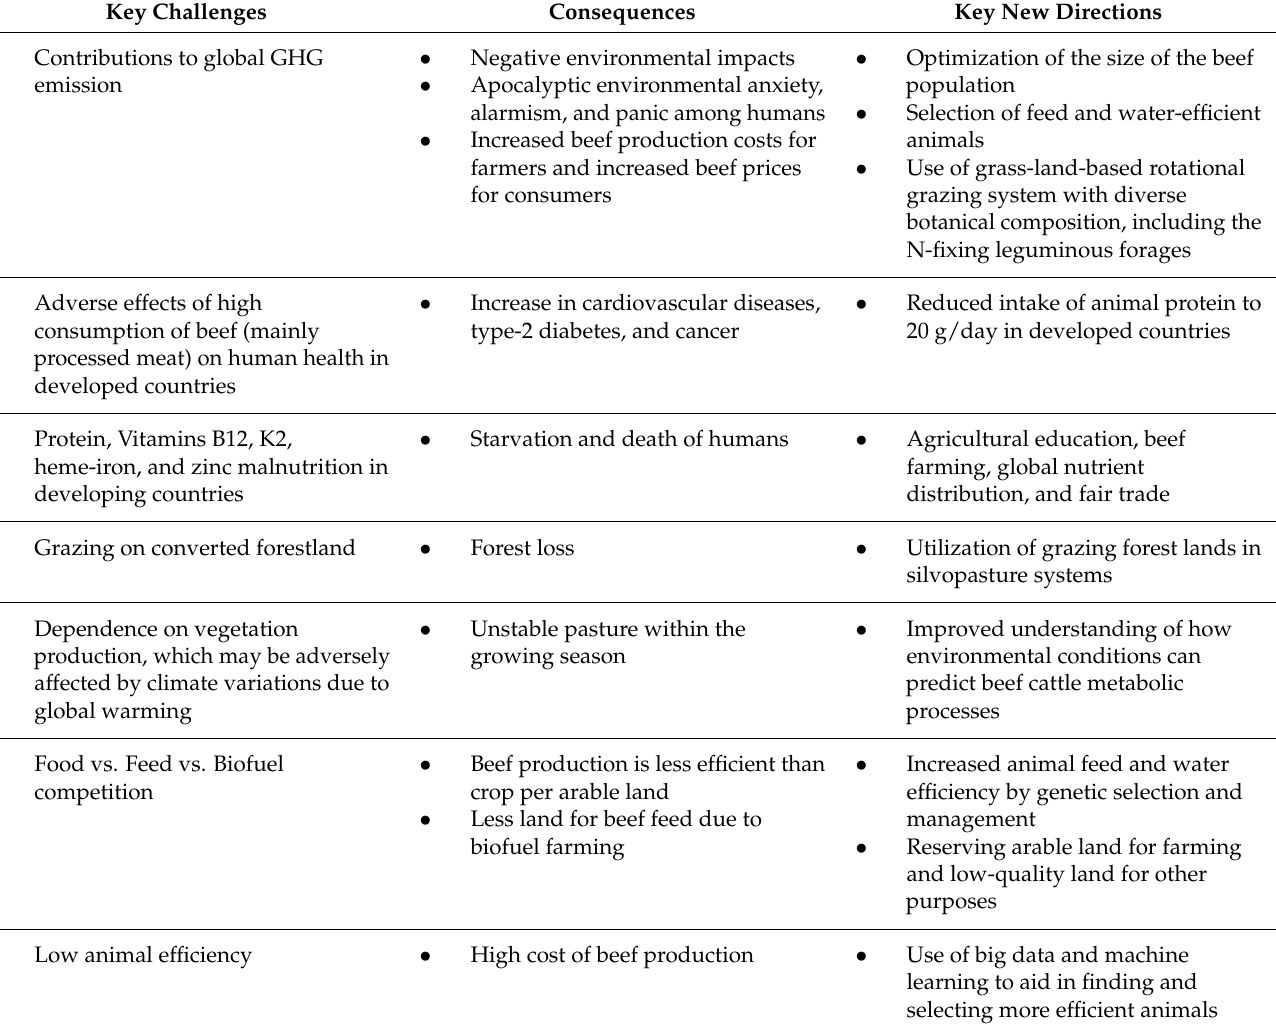
Table 1. Key challenges and potential directions forward in beef